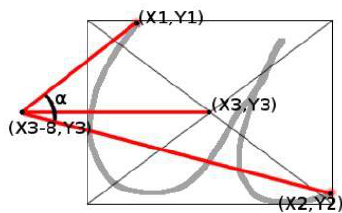
Figure 4. Example of point angle.